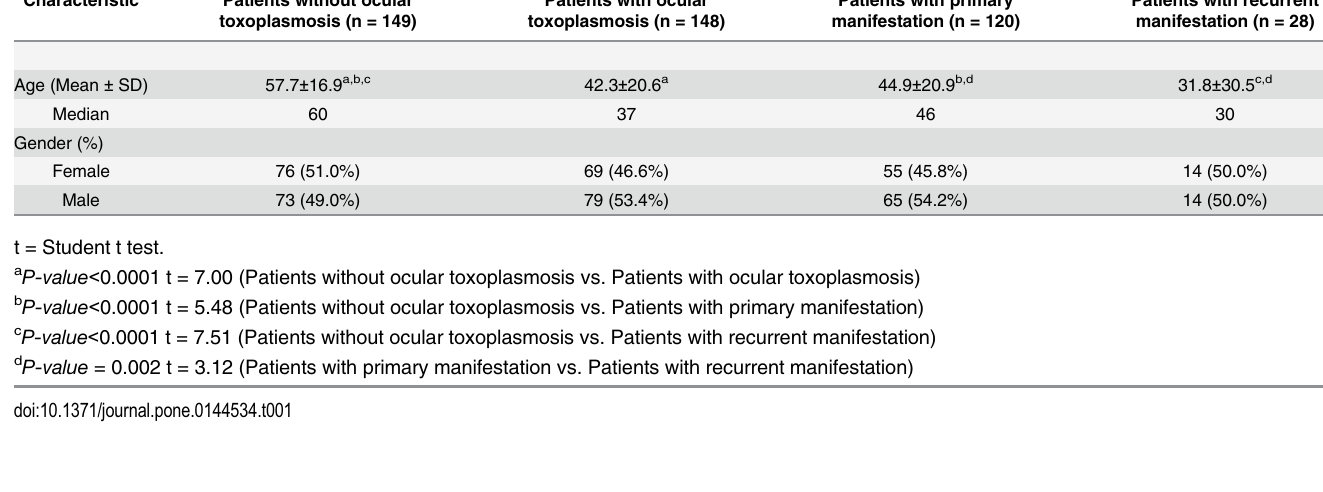
Table 1. General characteristics of patients with and without ocular toxoplasmosis and its manifestation as primary or recurrent Characteristic Patients without ocular Patients with ocular Patients with primary Patients with recurrent toxoplasmosis (n = 149) toxoplasmosis (n = 148) manifestation (n = 120) manifestation (n =